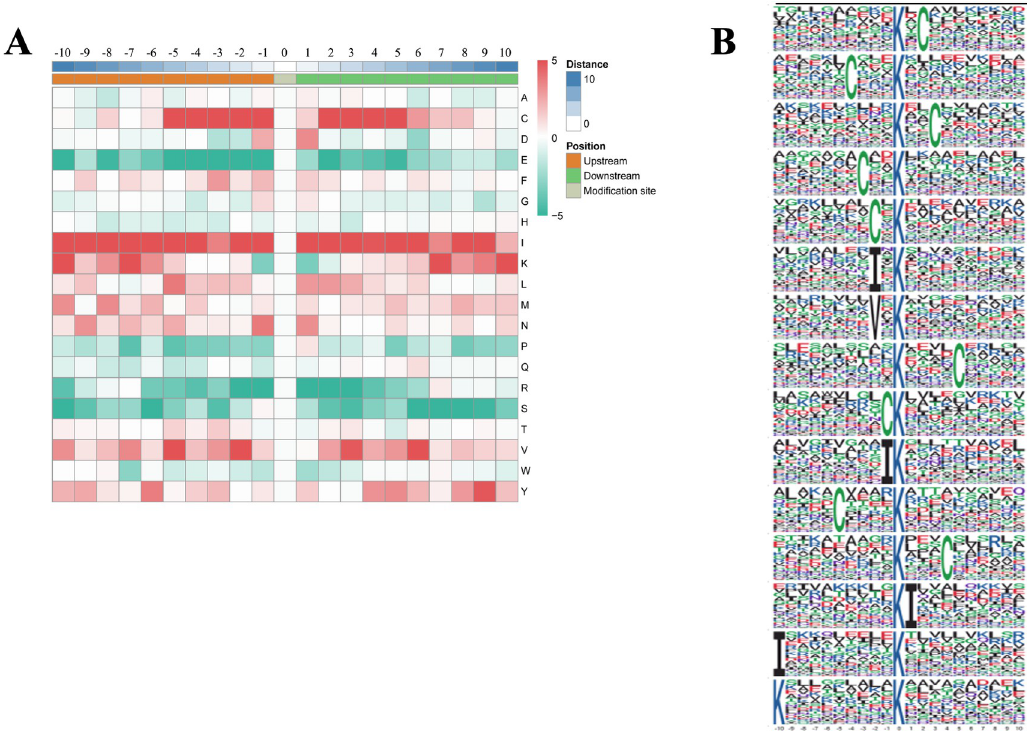
Fig 2. (A) Heat map of the different types of amino acids at positions − 10 to +10 from the malonylated lysine residue. Red and green colors denote high and low frequency, respectively. (B) Sequence motif logos showing the malonylation sites detected in proteins and the position-specific amino acids’ composition surrounding the malonylation